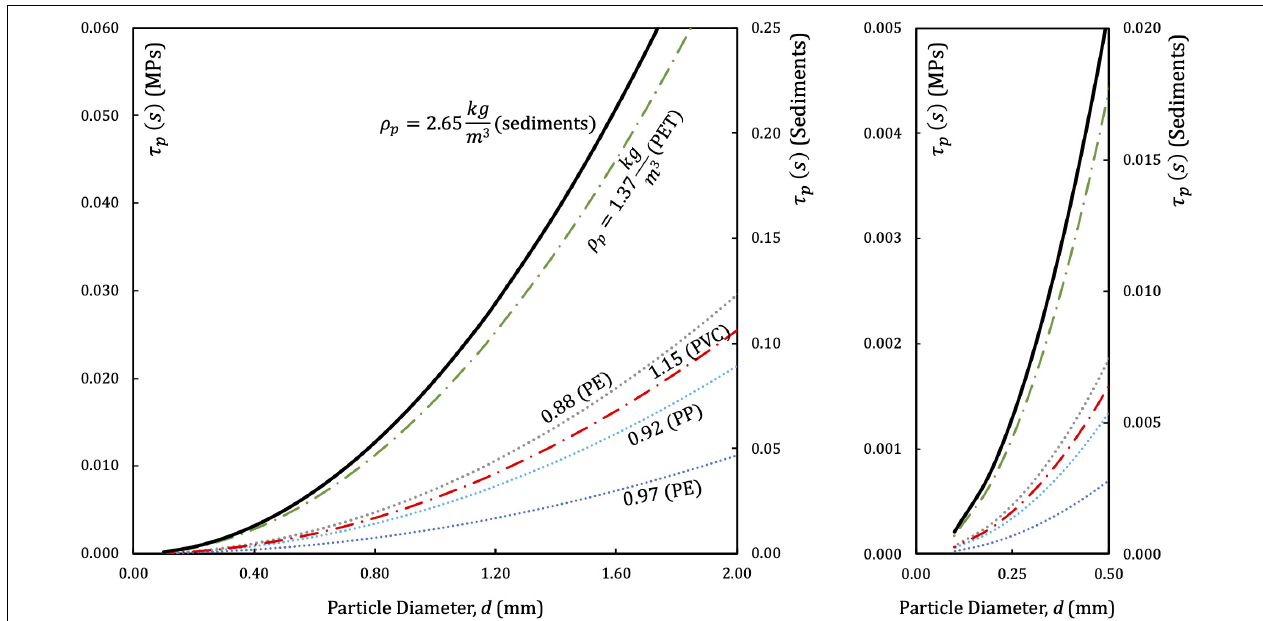
FIGURE 3 | Relaxation time, τ p , for sediment particles ( ρ p = 2.65 g/cm 3 ) and microplastic particles ( ρ p = 0.88–1.37 g/cm 3 ). Figure on the left shows τ p for particle sizes ranging from 0.1 to 2 mm, whereas figure on the right highlights the range for smaller sizes of 0.1–0.5